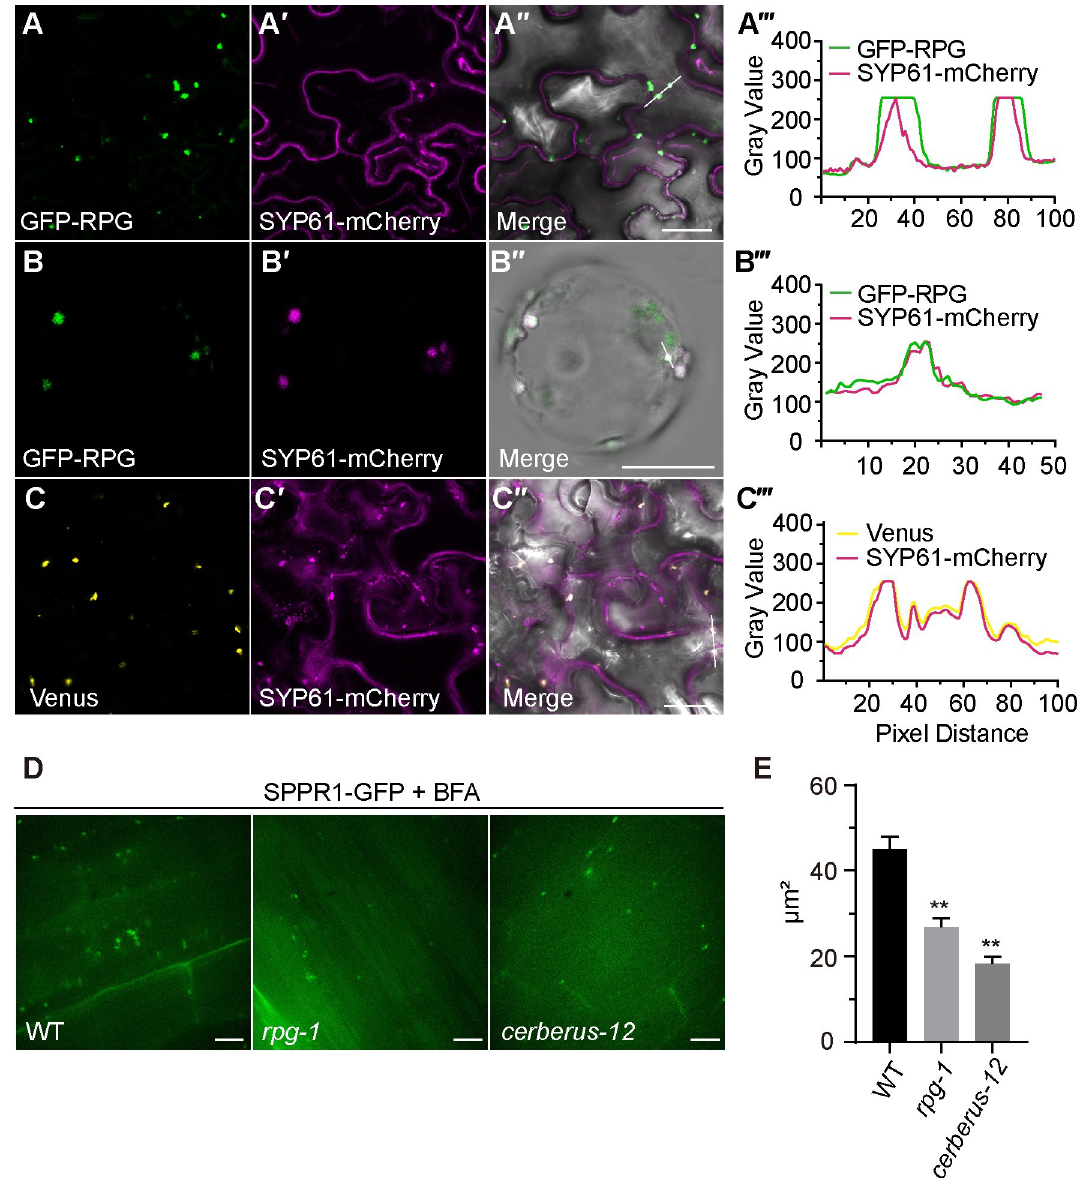
Fig 6. RPG interact CERBERUS at the TGN/EE compartment. (A-B) GFP-RPG (green) and TGN/EE marker SYP61-mCherry (magenta) were co-expressed in N . benthamiana leaf cells (A) or L . japonicus root protoplasts (B). (C) Co-expressed RPG-CERBERUS BiFC construct (yellow) and NLS-DsRed (magenta) in N . benthamiana leaf cells. Plots (A 000 -C 000 ) show fluorescence intensities of the regions of interest (indicated by white line in [A @ -C @ ]).(D) Confocal images of SPPR1-GFP in L . japonicus WT, rpg-1 and cerberus-12 transgenic roots inoculated with M . loti R7A/ lacZ 2 days after Brefeldin-A induced BFA body formation. E, Quantification of BFA bodies size in WT, rpg-1 and cerberus-12 expressing SPPR1-GFP after 2 h BFA treatment. Asterisks indicate significant differences (Students t -test), between mutants and WT (error bars represent SE). Scale bars: 25 μ m (A, C); 20 μ m (B); 200 μ m (D). accumulation of GFP-labeled endomembrane compartments into BFA bodies in all three lines (Fig 6D) but it was delayed in rpg-1 and cerberus-12 , resulting in the formation of smaller BFA bodies (Fig 6E). These results suggest that the RPG and CERBERUS may interact to function in endosome trafficking during IT formation.